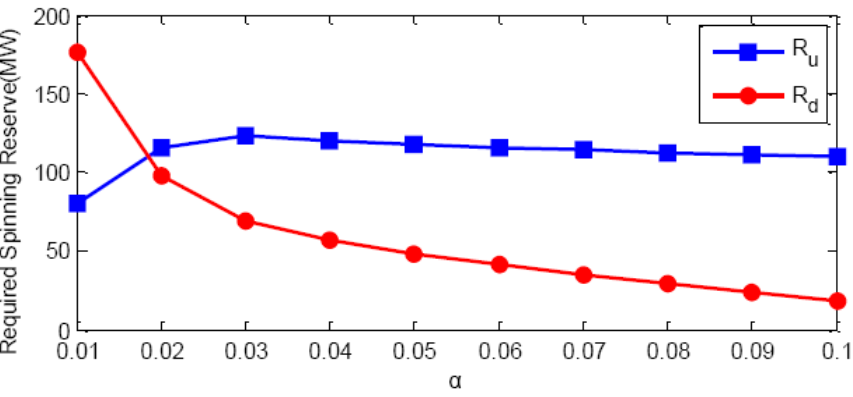
Figure 4. The required spinning reserve as a function of  .